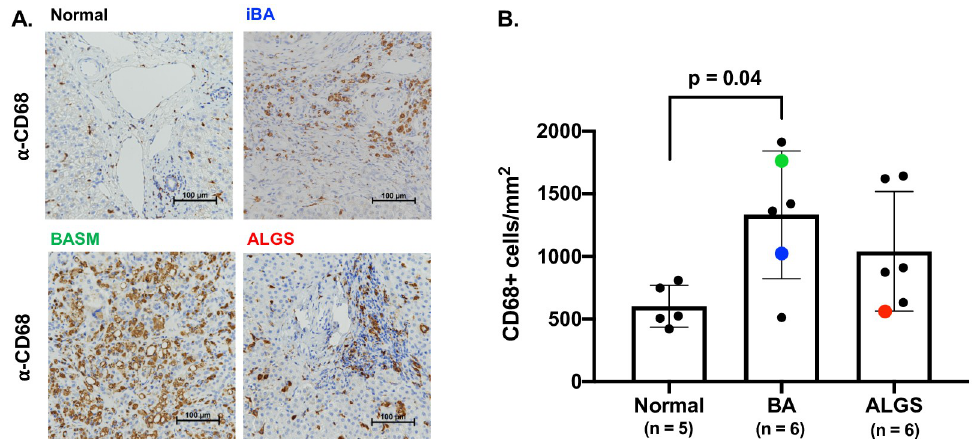
Fig 1. Increased hepatic macrophages in cholestatic liver disease. Representative immunohistochemistry staining with the macrophage marker anti-CD68 in samples taken at the time of liver transplantation from the iBA, BASM, and ALGS patients also used for scRNA-seq are shown compared to a normal donor liver sample (A). Quantitative analysis of entire sections from wedge biopsies showed a significantly increased number of CD68+ macrophages in BA patients, with individual samples processed for scRNA-seq shown in blue (iBA), green (BASM) and red (ALGS)